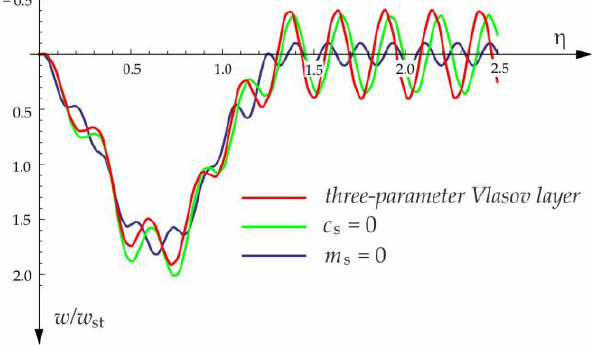
Figure 13. Foundation parameters ’ effect on the beam midpoint deflection. Beam subjected to the group of two forces moving at a constant distance of 1.5 m a = and a velocity of 50 m s v = . 3.3. Bernoulli – Euler Beam on Vlasov Foundation Subjected to a Group of Three Moving Forces In the case of three moving forces, spaced at a constant distance a and moving at a uniform velocity v , according to Figure 14, the equation of the beam forced vibrations is given by Equation (26): x vt a